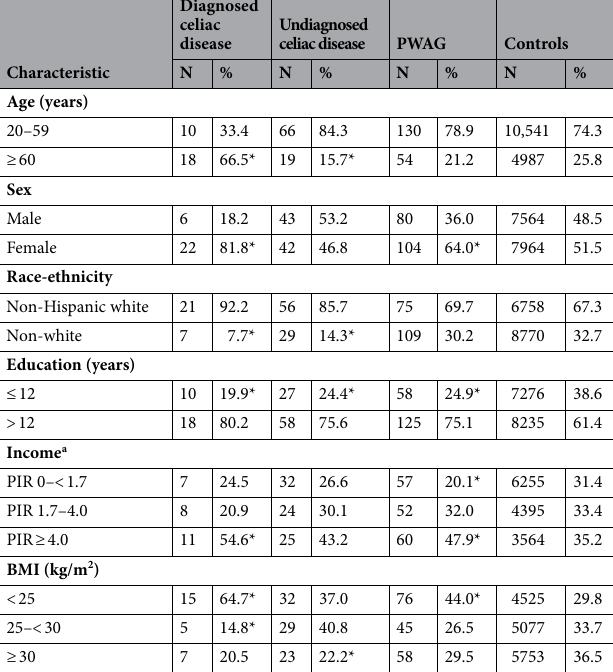
Table 1. Characteristics of NHANES participants 20 years and older with and without celiac disease and PWAG, United States, 2009–2014. NHANES, National Health and Nutrition Examination Survey; PIR, poverty income ratio; PWAG, persons without celiac disease avoiding gluten. a PIR is family income to poverty threshold ratio. Cut points were tertiles. * p < 0.05 compared with